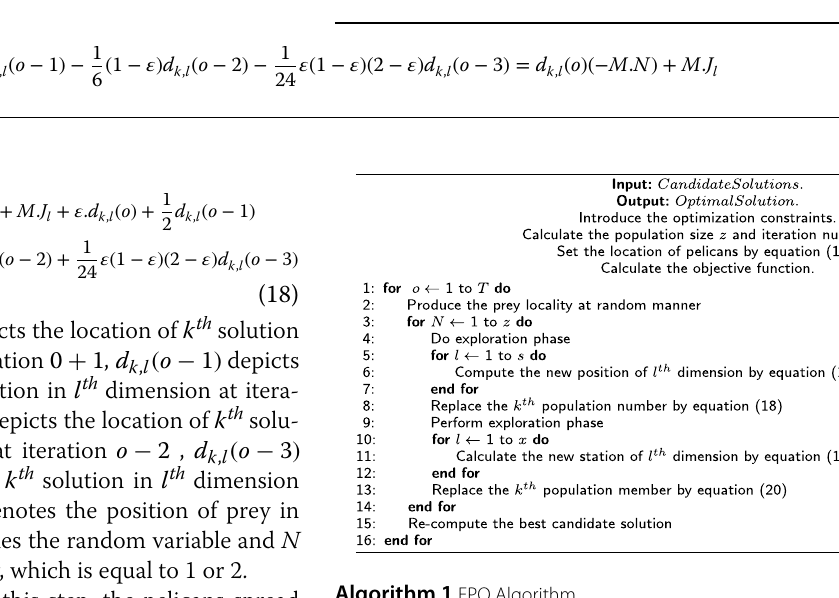
Scaling setup and